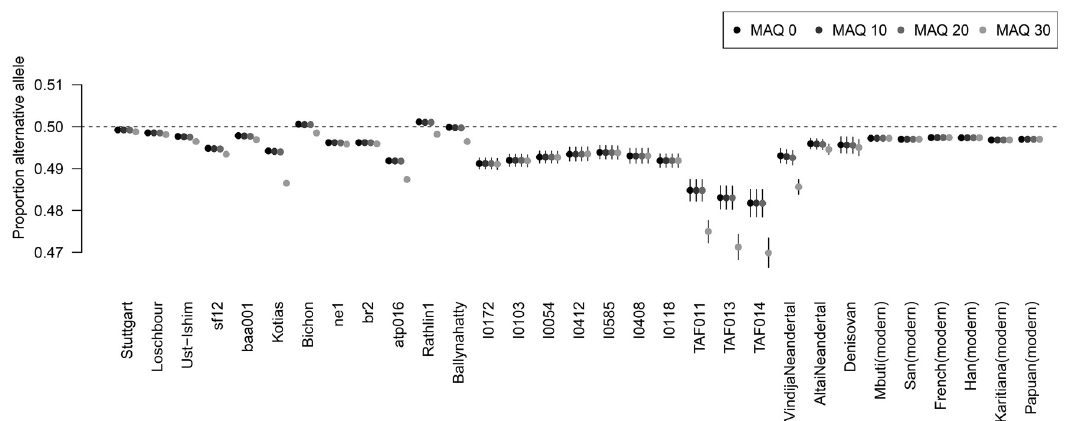
Fig 1. Reference bias in published genome-wide ancient DNA datasets for different minimum mapping quality thresholds. The plot shows the average proportion of reads at heterozygous transversion sites (see Methods) representing the alternative allele. Error bars indicate two standard errors of the